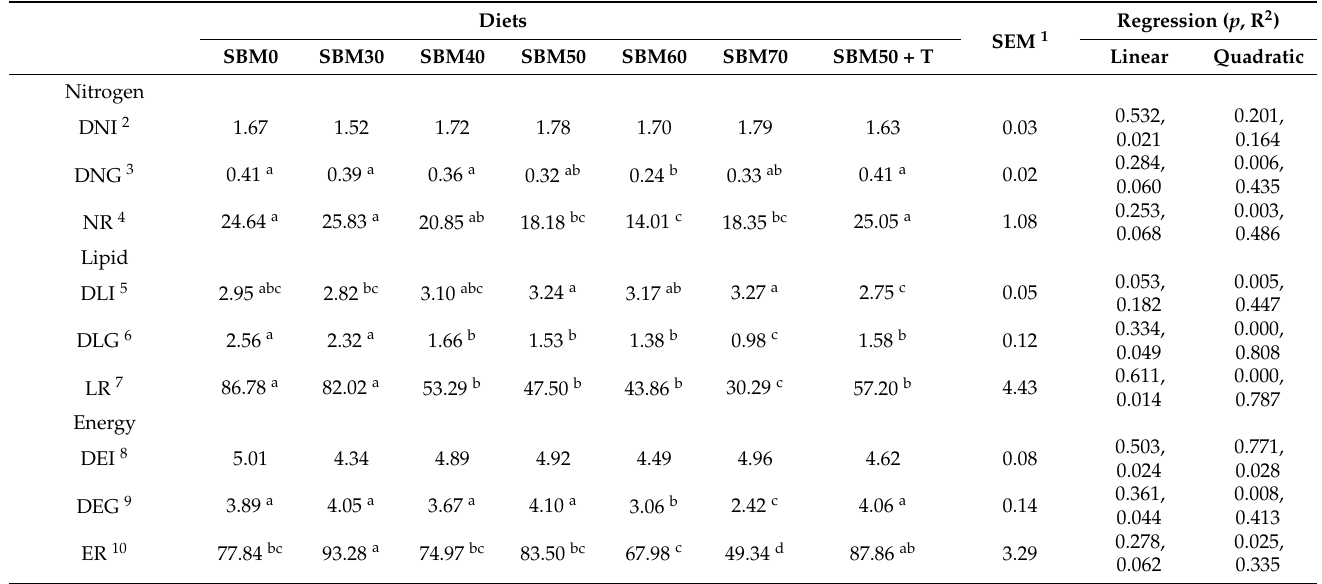
Table 7. Nitrogen, energy, and lipid utilization in juvenile Oplegnathus punctatus fed diets containing different levels of soybean meal.